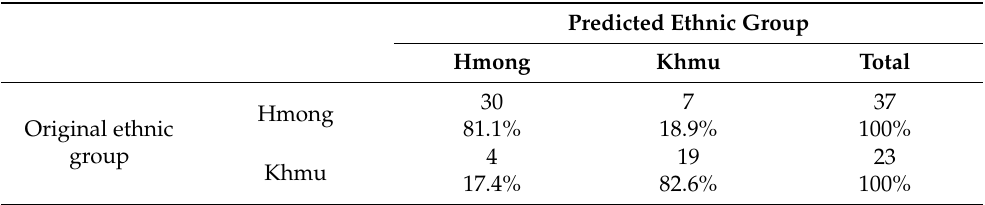
Table 5. Results of a canonical discriminant analysis (CDA) using the explanatory variables mentioned in Table